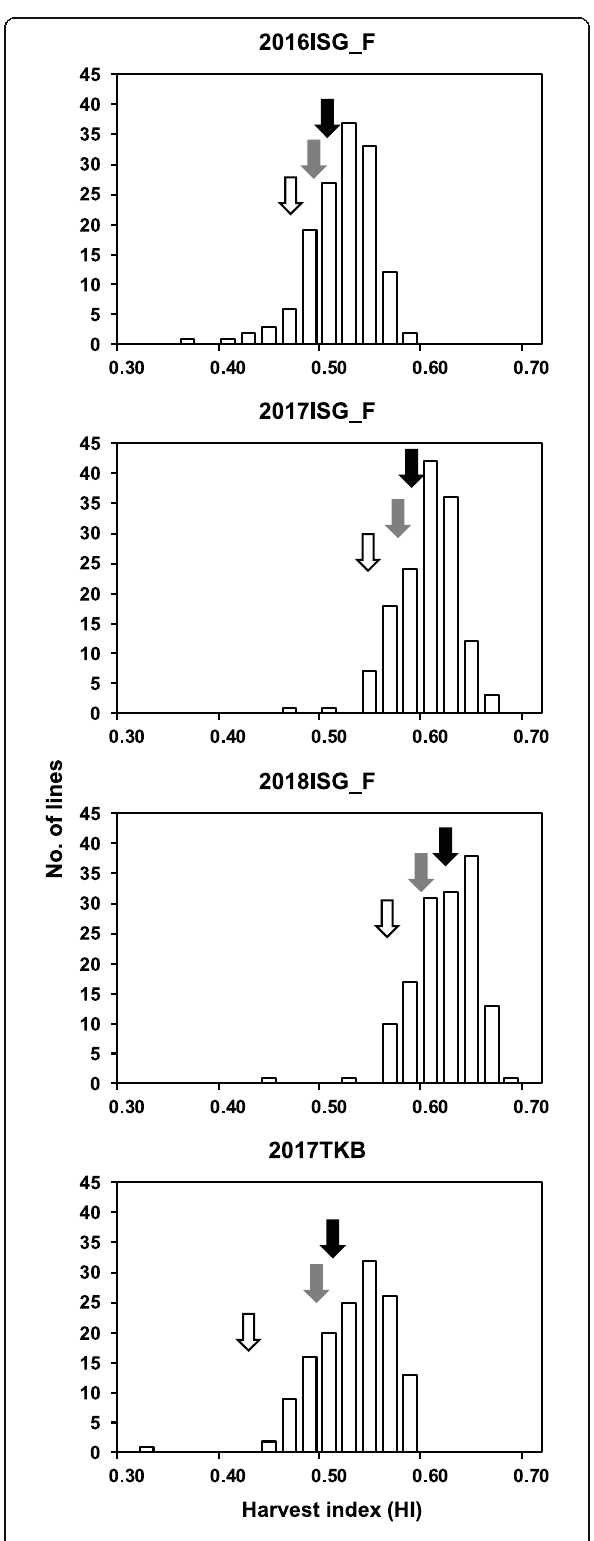
Fig. 2 Frequency distributions of HIs of RILs in the cropping seasons at Ishigaki (ISG) and Tsukuba (TKB). The white, black, and gray arrows indicate, respectively, the HI of IR 64, YTH183, and the average of the RILs